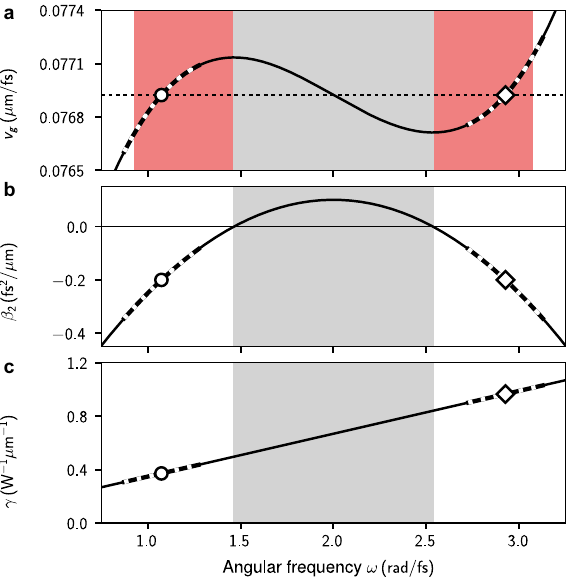
Figure 1. Specifics of the considered z -propagation model. ( a ) Frequency dependence of the group velocity. Frequency ranges shaded in red allow for group-velocity matched co-propagation of light pulses in separate regions of anomalous dispersion. Horizontal dashed line indicates reference velocity v 0 . ( b ) Group velocity dispersion profile. ( c ) Nonlinear coefficient function. In all subplots, normally dispersive frequency ranges are shaded gray. Open circle and open square indicate the loci of ω GVM1 and ω GVM2 , respectively. Thicker dashed parts of curves indicate the angular frequency ranges covered by the parameter sweep. Polynomial models for β(ω) and γ(ω) are detailed in the main